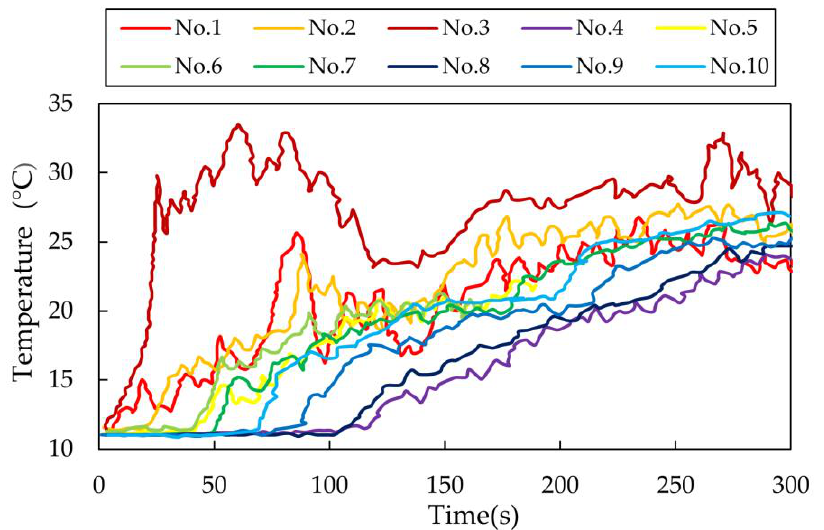
Figure 3. Temperature measurement at selected points in non-isothermal water model (Q = 2000 l/h, H = 0.4 m, ΔT = 30 °C). Table 3. Breakthrough time of different thermocouples.